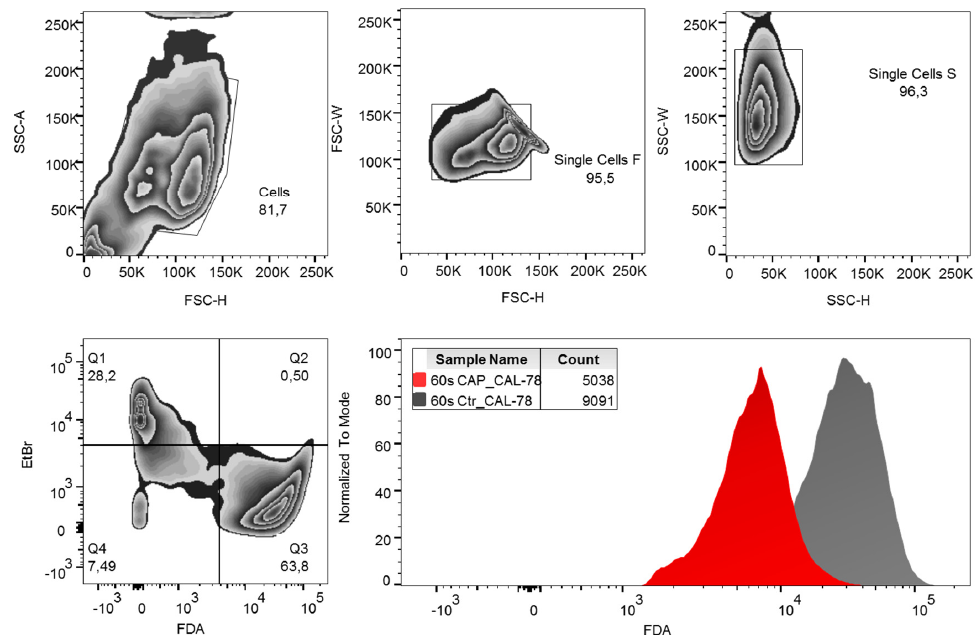
Figure 7. Gating strategy. Fluorescein diacetate (FDA) content per cell was analyzed by flow cytometry. Debris and doublets were excluded by forwarding and side-scatter characteristics. Living cells were defined as ethidium bromide (EtBr)-negative and FDA-positive events. For analysis of data, the mean fluorescence intensity (MFI) of FDA was compared. SSC-A: side-scatter area, SSC-H: side-scatter height, FSC-W: forward-scatter width, FSC-H: forward-scatter